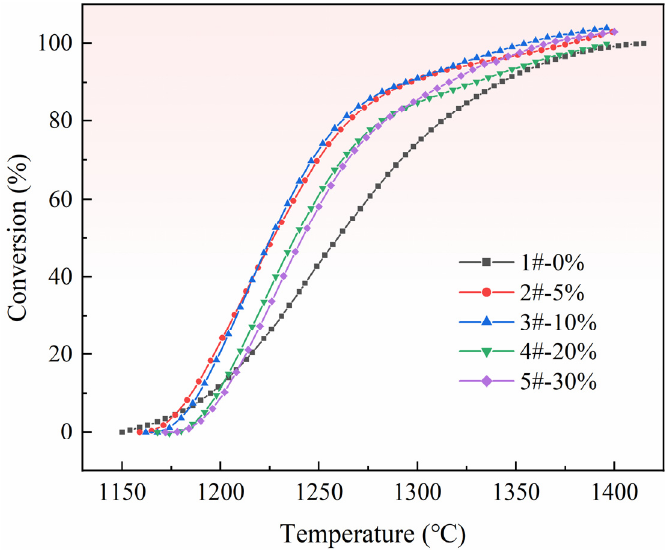
Figure 10. Change in reduction conversion of magnesium in pellets with different rations of pore- forming agent.